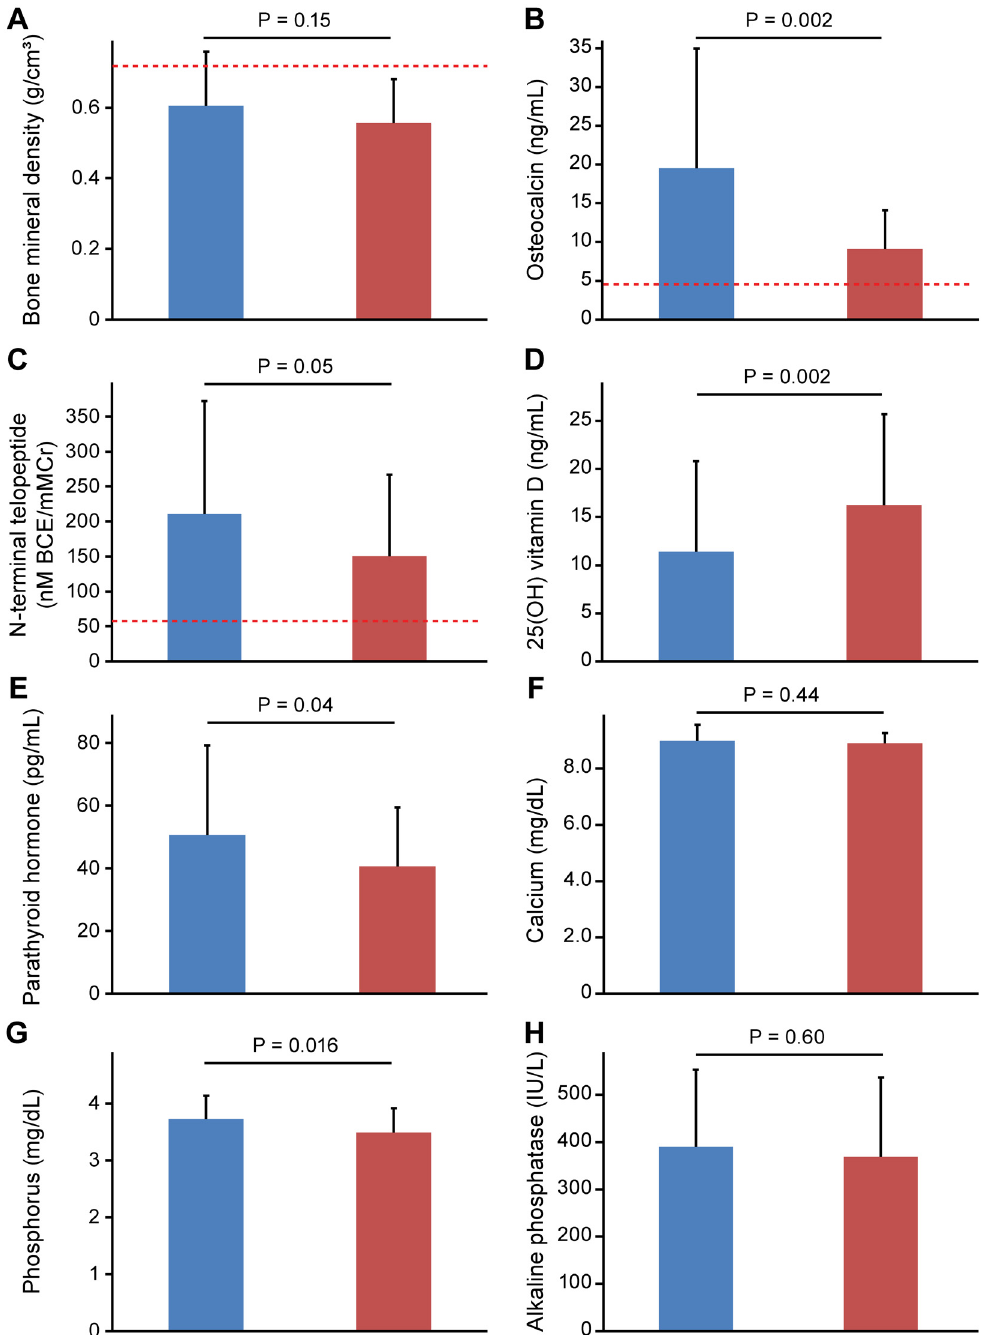
Fig 2. Changes in the bone mineral density and bone metabolism marker levels during a 12-year follow-up period in patients whose baseline age was < 30 years. Red lines indicate the cutoff value for osteoporosis (bone mineral density) and those for predicting bone fracture (osteocalcin and N-terminal telopeptide), as proposed by the guidelines for the prevention and treatment of osteoporosis [17].